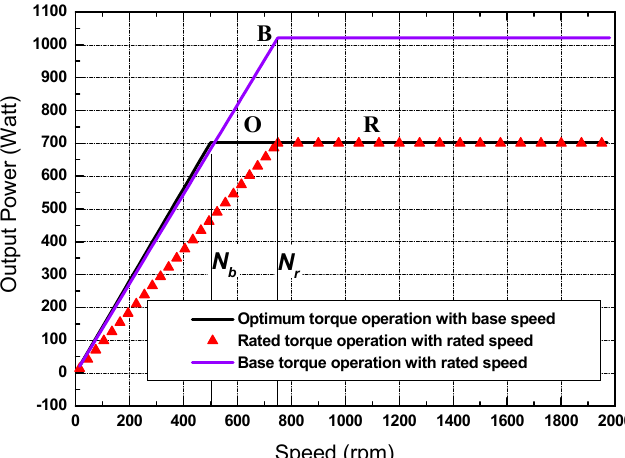
Figure 14. Electric vehicle (EV) motor torque/speed patterns.